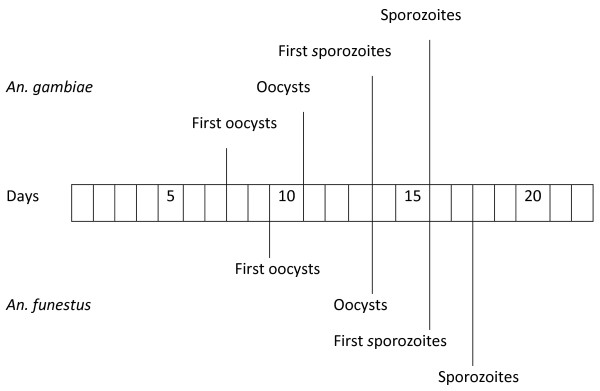
A comparative timeline of P. berghei development in An. gambiae and An. funestus.